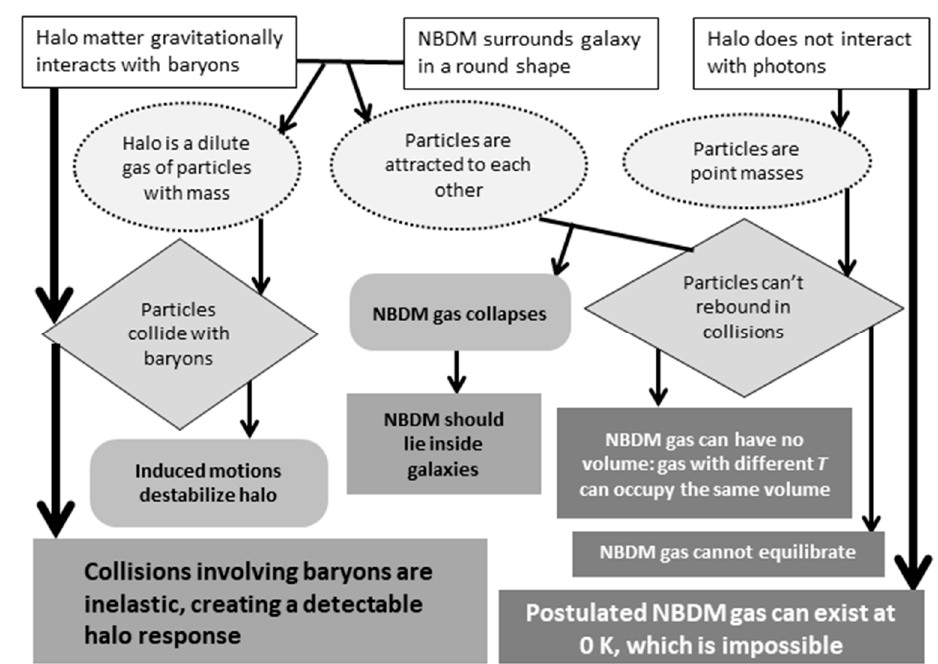
Figure 6. Schematic showing thermodynamic consequences of the postulated behavior of NBDM in galactic halos. Black arrows trace implications, where subhorizontal lines indicate considerations being applied simultaneously and heavy arrows emphasize key deductions. White boxes list postulated behavior of NBDM in halos; pale ovals indicate consequences for the nature of NBDM; various grey shapes indicate additional consequences; very dark grey boxes indicate violations of thermodynamic laws.